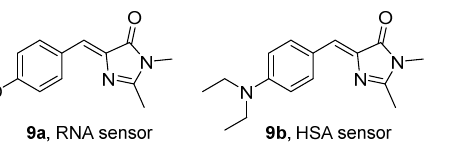
Figure 9. GFPc analogues used as selective fluorescence turn-on molecular probes for RNA and HSA [23].